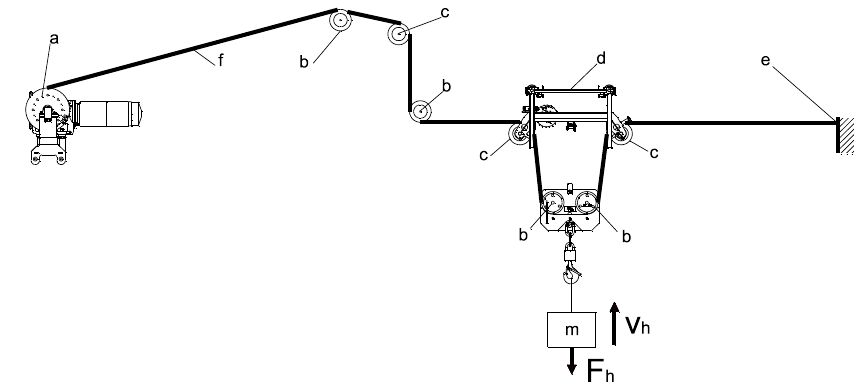
Figure 6. The diagram of the main hoist rope: ( a ) the hoist drum, the cast iron ( b ) and polyamide ( c ) wheels on the turntable, ( d ) the trolley, ( e ) rope attachment point (swivel), ( f ) rope.